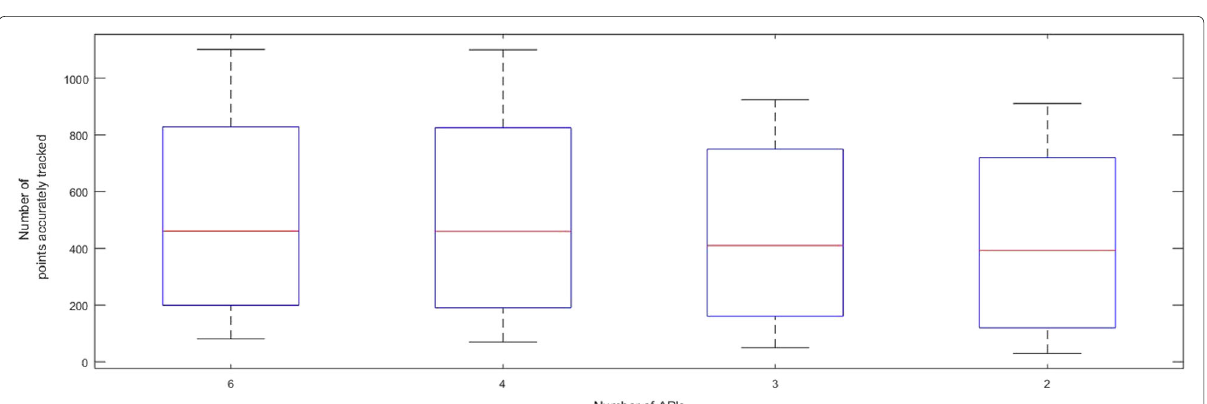
Fig. 7 Points accurately tracked v/s number of tuples in dataset for 2, 3, 4, and 6 AP’s respectively